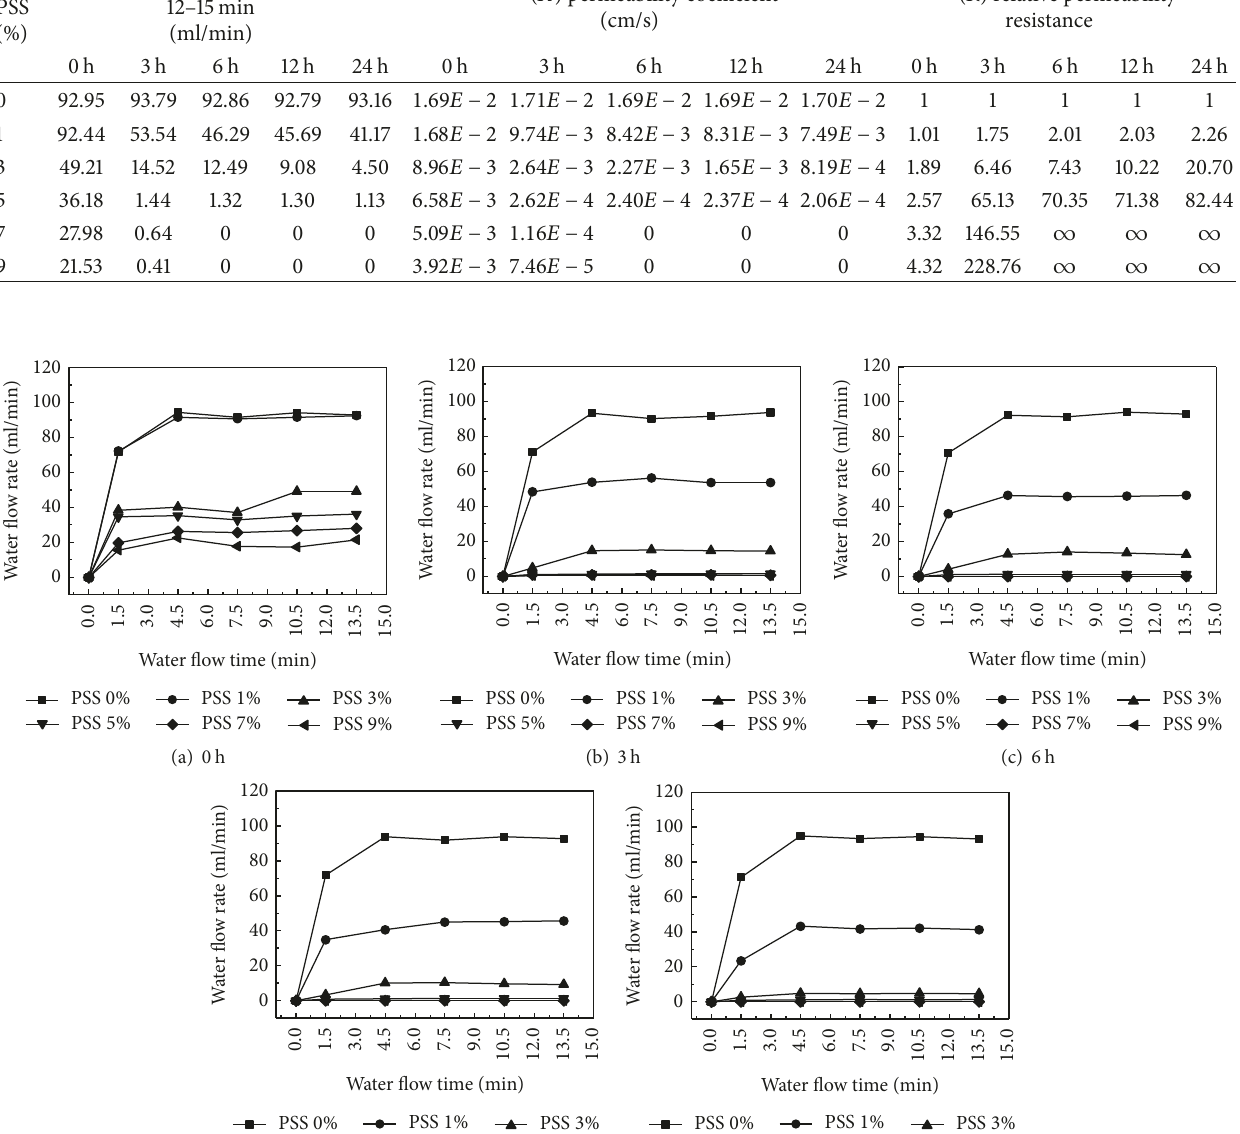
7% and 9% with curing time larger than 6 hours cannot